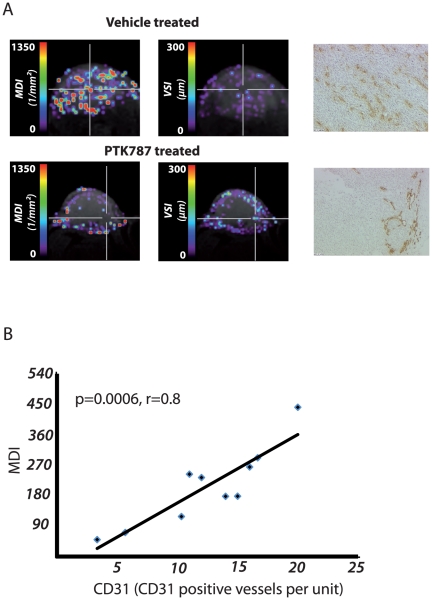
Comparison of the image derived values of MDI and VSI to CD31 positive endothelial cell staining.(A) a vehicle treated (upper row) tumor presenting a high microvessel density index (MDI (1/mm2)) in MRI and a low vessel index (VSI (µm)). The PTK787-treated tumor (lower row) presents low MDI values with high VSI values. (B) correlation between CD31 positive vessels per area unit and the imaged derived MDI values (n = 10).